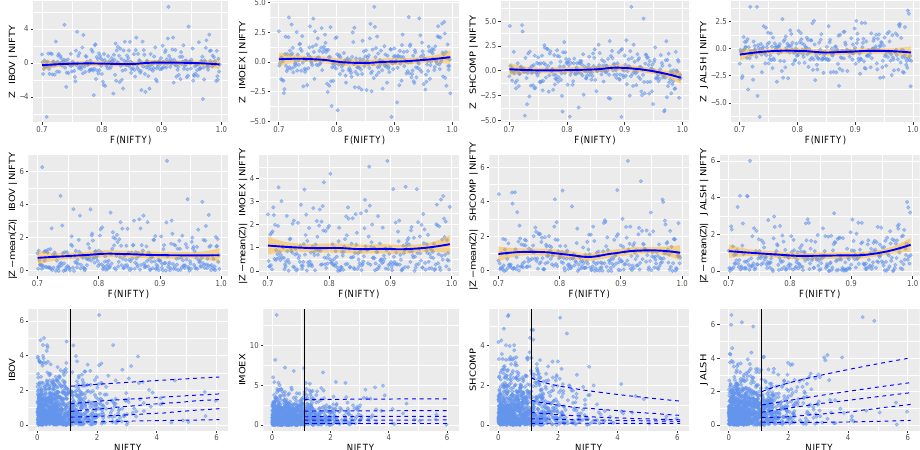
Figure A4. Dependence model diagnostics: conditioning on the NIFTY variable.